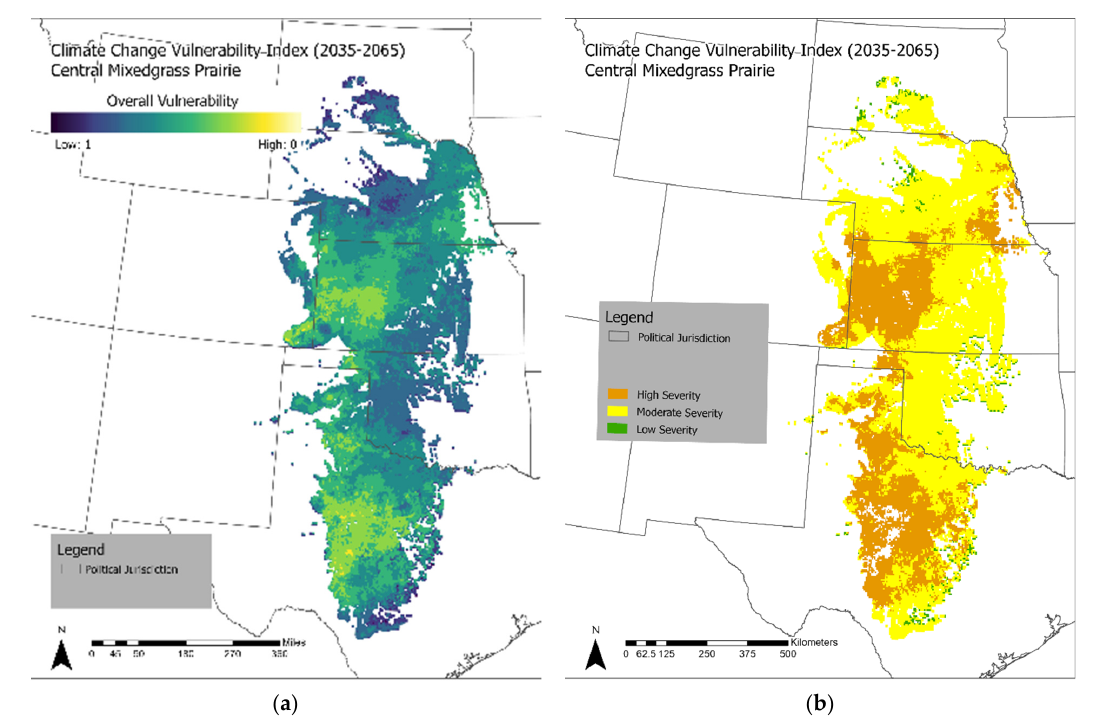
Figure 4. ( a , b ) Overall climate change vulnerability for 2035–2065 and translated Severity estimate ( a ), both summarized by 4 × 4 km 2 pixels for Central Mixedgrass Prairie, with 55% scores as moder- ate severity and 44% scores as high severity ( b